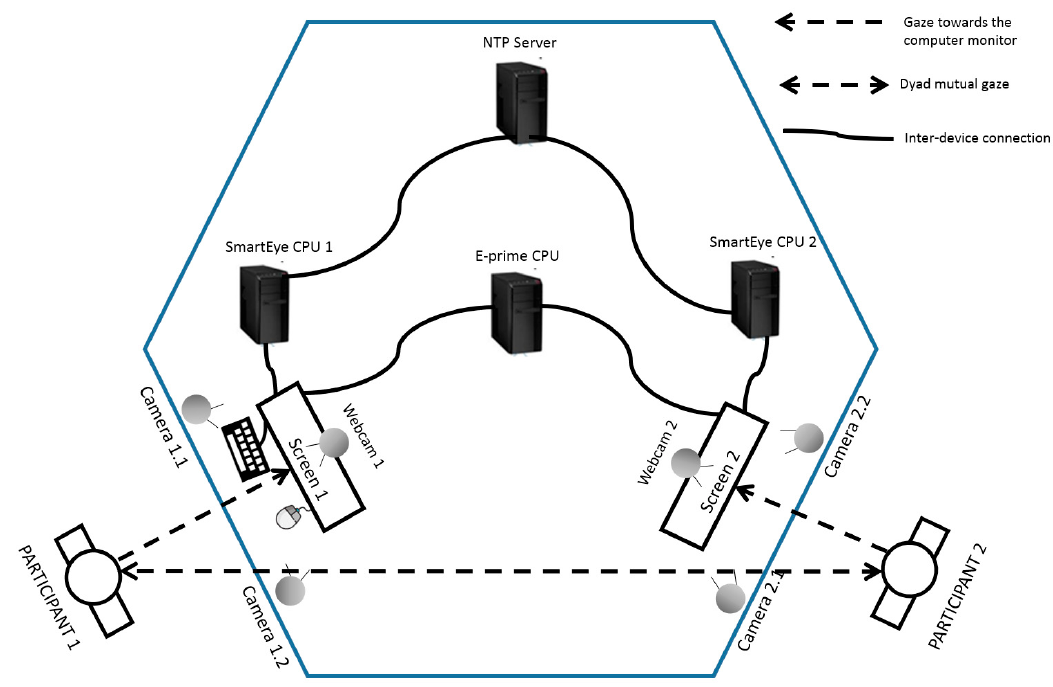
Figure 3. Eye-tracking experimental setup.